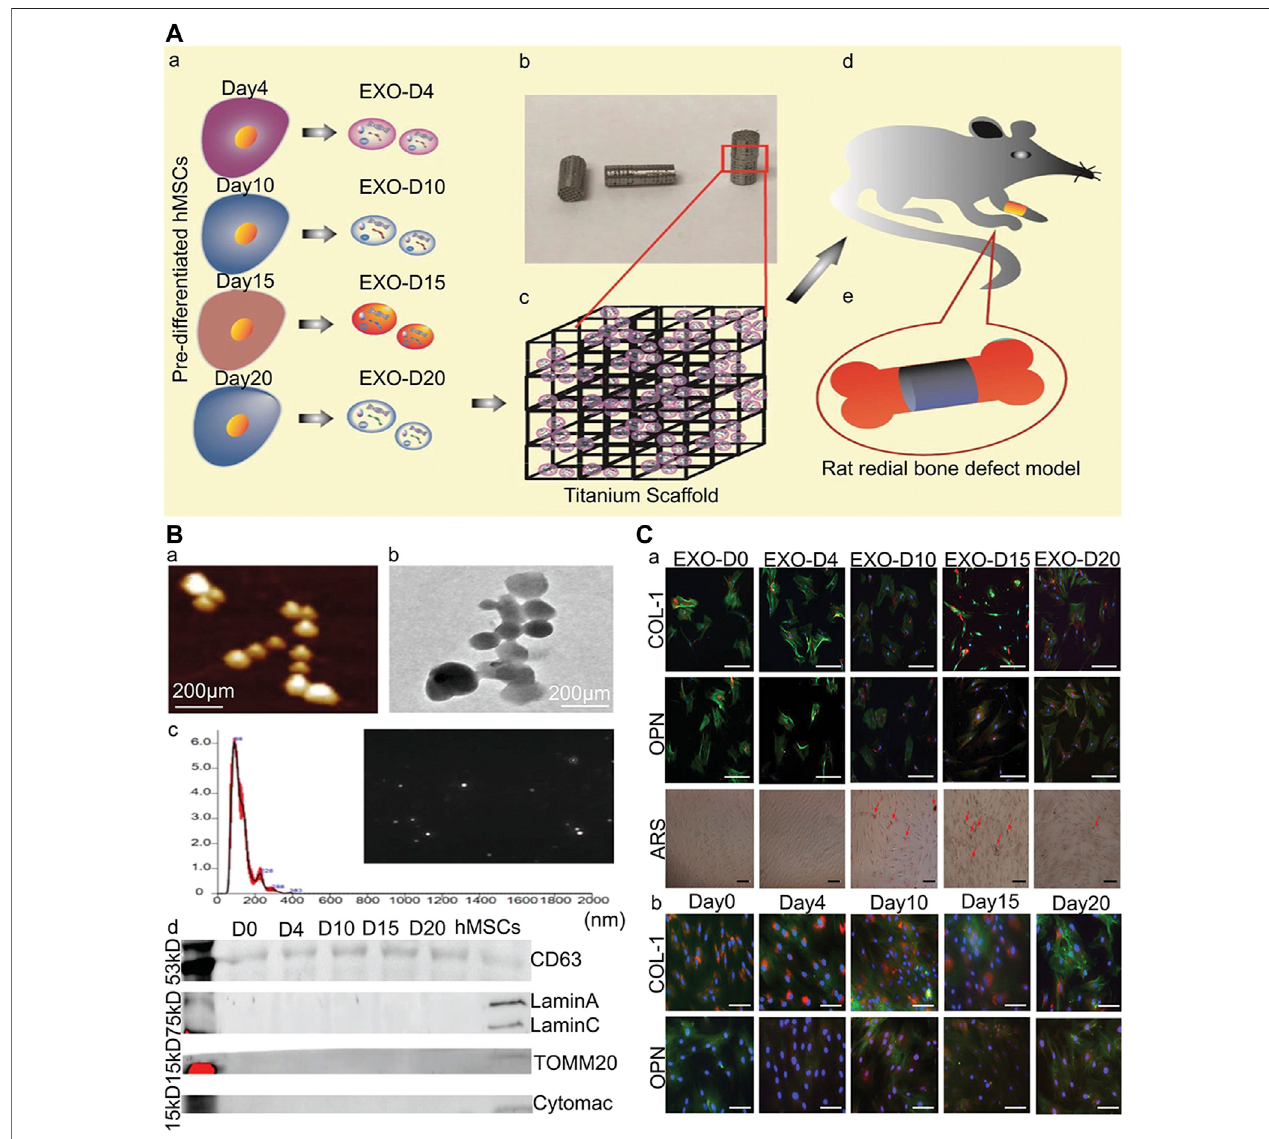
FIGURE 7 | Osteogenic exosomes induce osteogenic differentiation (Zhai et al., 2020). (A) The schematic illustration of cell-free bone tissue regeneration by the stemcell-derivedexosomes. (B) Thecharacterizationofthestemcell-derivedexosomes.a)AFMandb)TEMshowingthesizeandmorphologyoftheexosomesderived fromhMSCs.Scalebar:200 nm.c)ThesizeandconcentrationofthehMSCs-derivedexosomesbytheNanosightNS300.Theinsetisanimageshowingthesnapshotof video tracking. d)Thewesternblotanalysisoftheexosomederivedfrom thepre-differentiatedhMSCsandhMSCs. (C) OsteogenicdifferentiationofhMSCsbythe osteogenic exosomes a) Immuno fl uorescence staining of osteogenic markers (COL-1, OPN) in hMSCs induced by osteogenic exosomes. b) Immuno fl uorescence staining of osteogenic markers (COL-1, OPN) in hMSCs induced by osteogenic medium. There was no signi fi cant difference between osteogenic exosomes treatment and osteogenic medium treatment, which proved the osteogenic induction function of osteogenic exosomes.